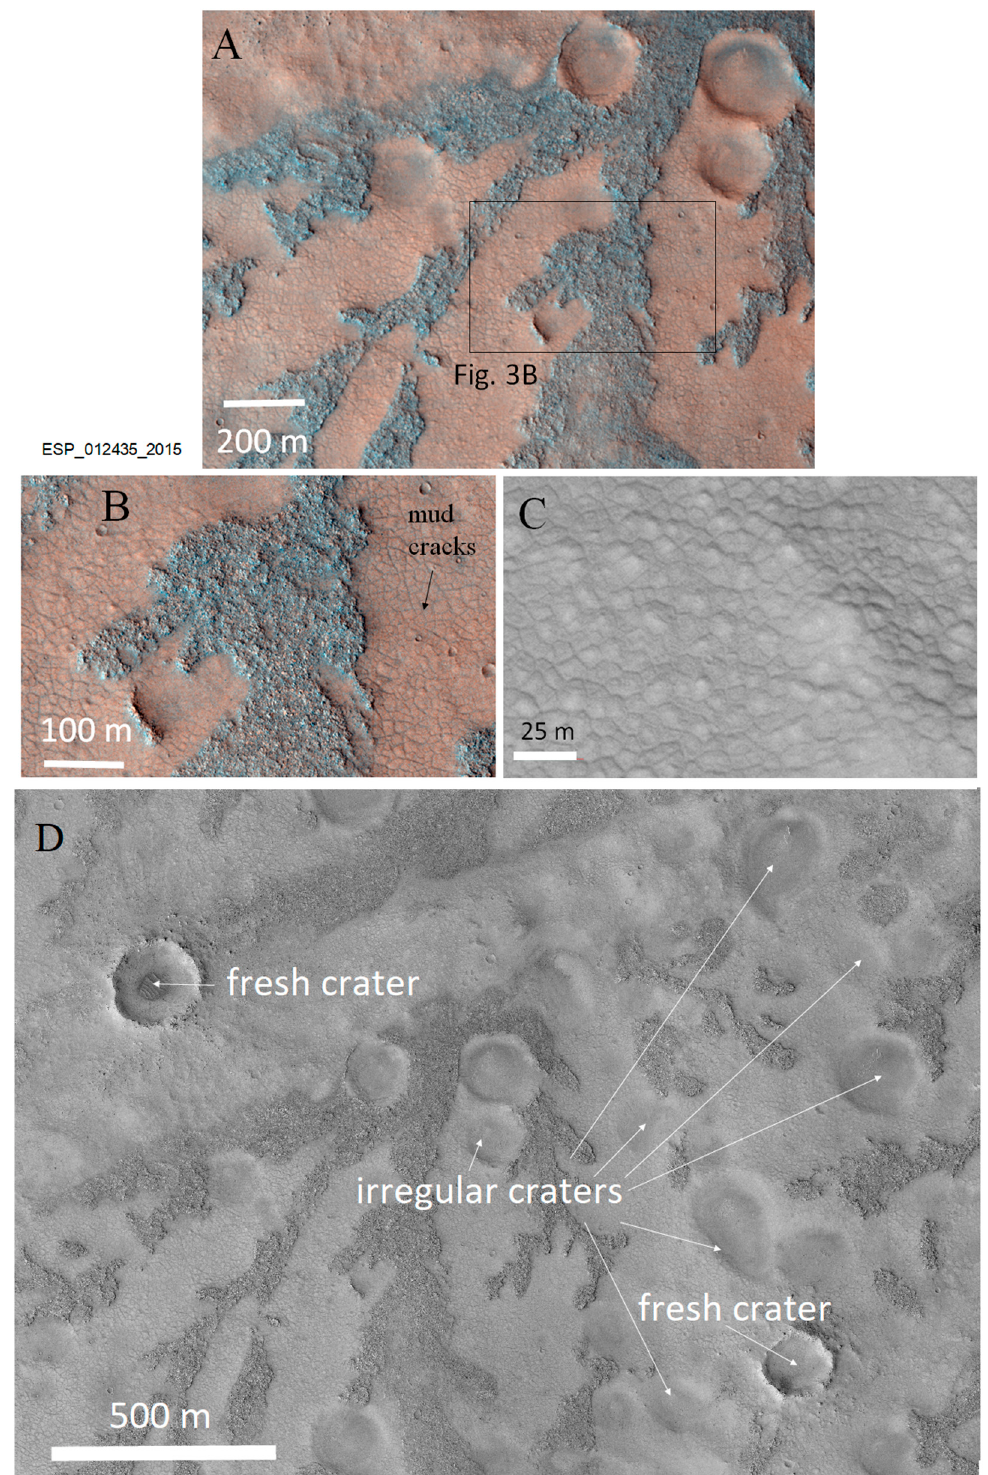
Figure 3. Appearance of the dendrites in the central unit (area shown in Figure 2A). HiRISE image ESP_012435_2015. ( B ) Enlarged rectangle in ( A ). ( C ) Enlarged image to show the polygonal ground (area outside Figure 3A). ( D ) Image of fresh and irregular impact craters on the putative lacustrine floor. The three craters in the center are the same appearing in the top-right of ( A ). All HiRISE images courtesy of NASA/JPL/University of Arizona.